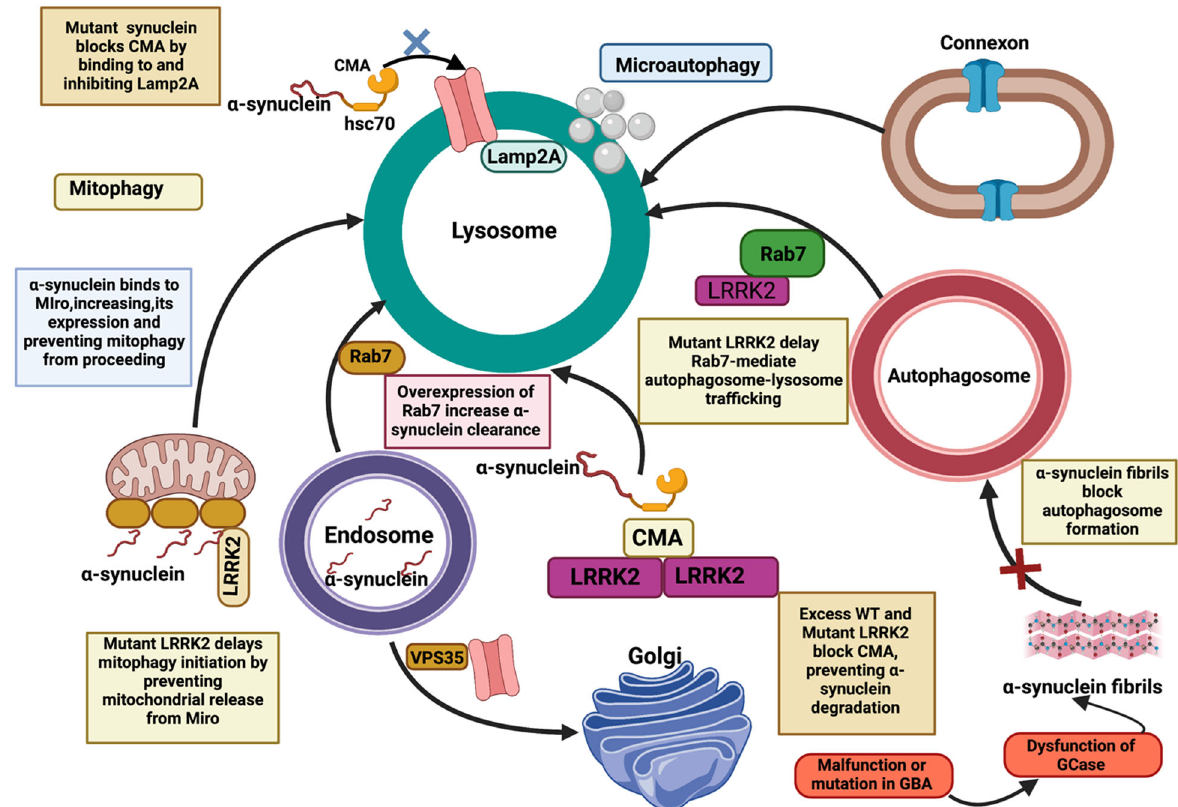
Fig. 10 Cross connection between α -synuclein-GBA-LRRK2 axis and ion-channels/gap-junctions to develop PD. This is an example of convergent processes between LRRK2, GBA, and α -synuclein, with both impacting the autophagy-lysosomal system but acting on different targets within the system. CMA and autophagosome formation can be blocked by mutant or aggregated α -synuclein, and mutant LRRK2 can likewise impede CMA, impair mitophagy, and delay autophagosome traf fi cking. Malfunction in GBA can lead to the production of less active or inactive GCase thereby leading to aggregation of α -synuclein. This LRRK2-GBA- α -synuclein axis can also interfere with diverse neuronal ion- channels and gap-jucntions to PD pathogenesis. CMA Chaperone-mediated autophagy, Lamp2a lysosome-associated membrane protein